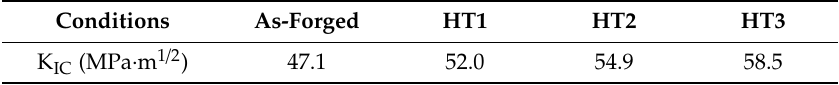
Table 4. Fracture toughness (K IC ) values for the 7.5 vol.% TiB w / Ti composites under di ff erent conditions.